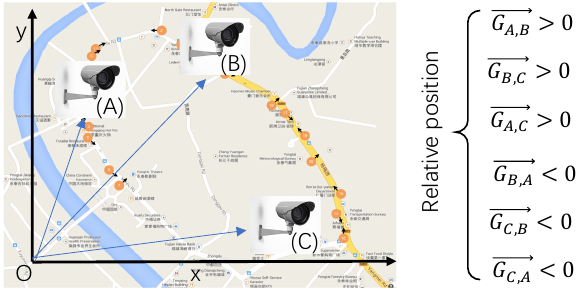
Figure 9. Relative geographic relationship between camera